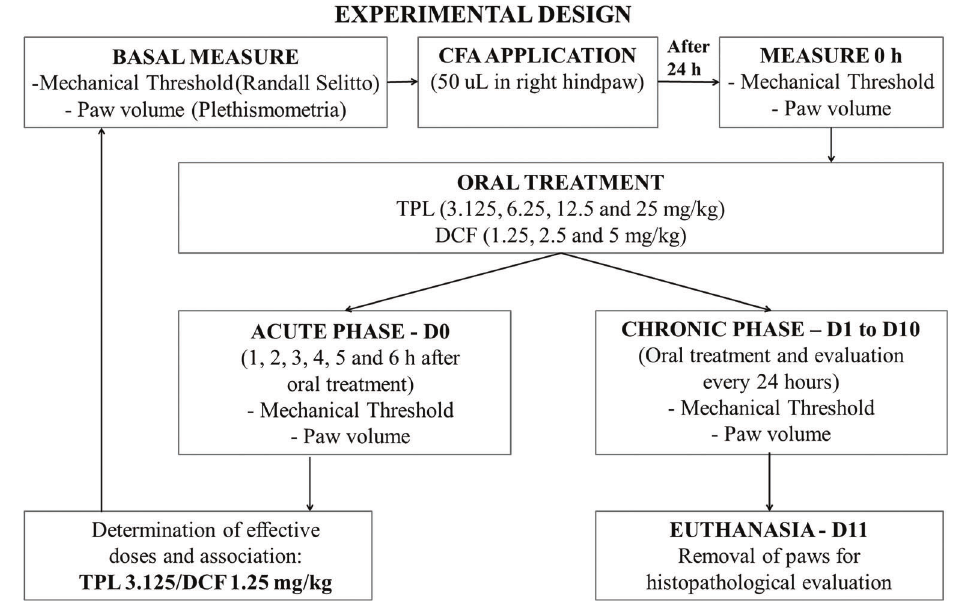
Figure 2. Experimental design. CFA: complete Freund ’ s adjuvant; TPL: terpinolene; DCF: